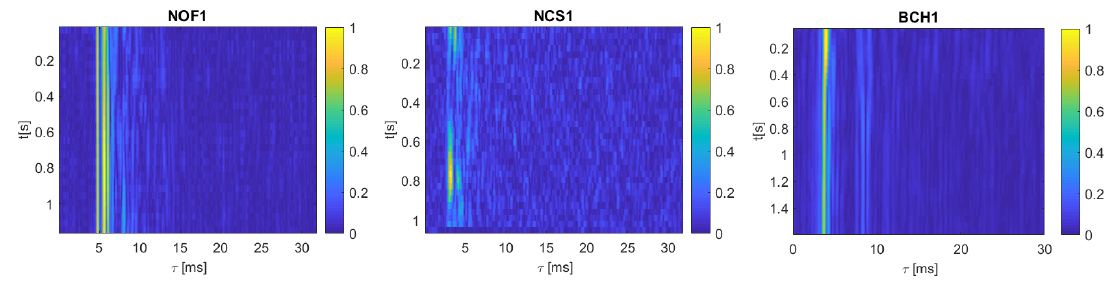
Figure 2. The module of exemplary time-varying impulse responses of Watermark